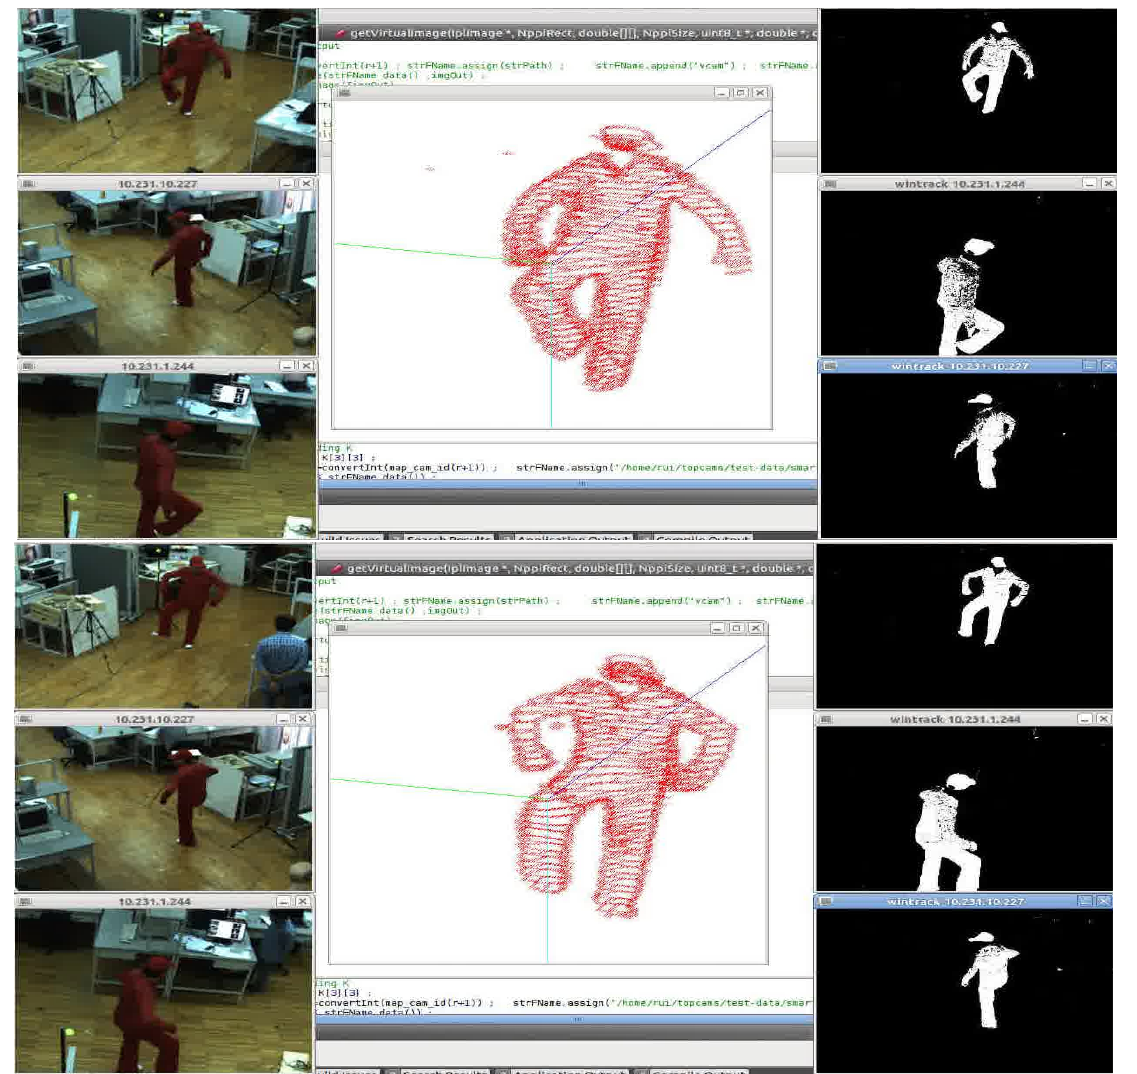
Figure 14. Online, real-time streaming of our 3D reconstruction results for a dynamic movement of a leg of a